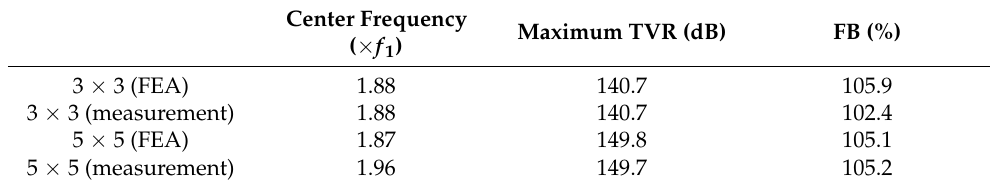
Figure 20. Schematic diagram of the experimental setup for TVR measurement. Table 5. Quantitative comparison of acoustic characteristics of the two-layered 3 × 3 and 5 × 5 cymbal arrays based on FEA and measurement.